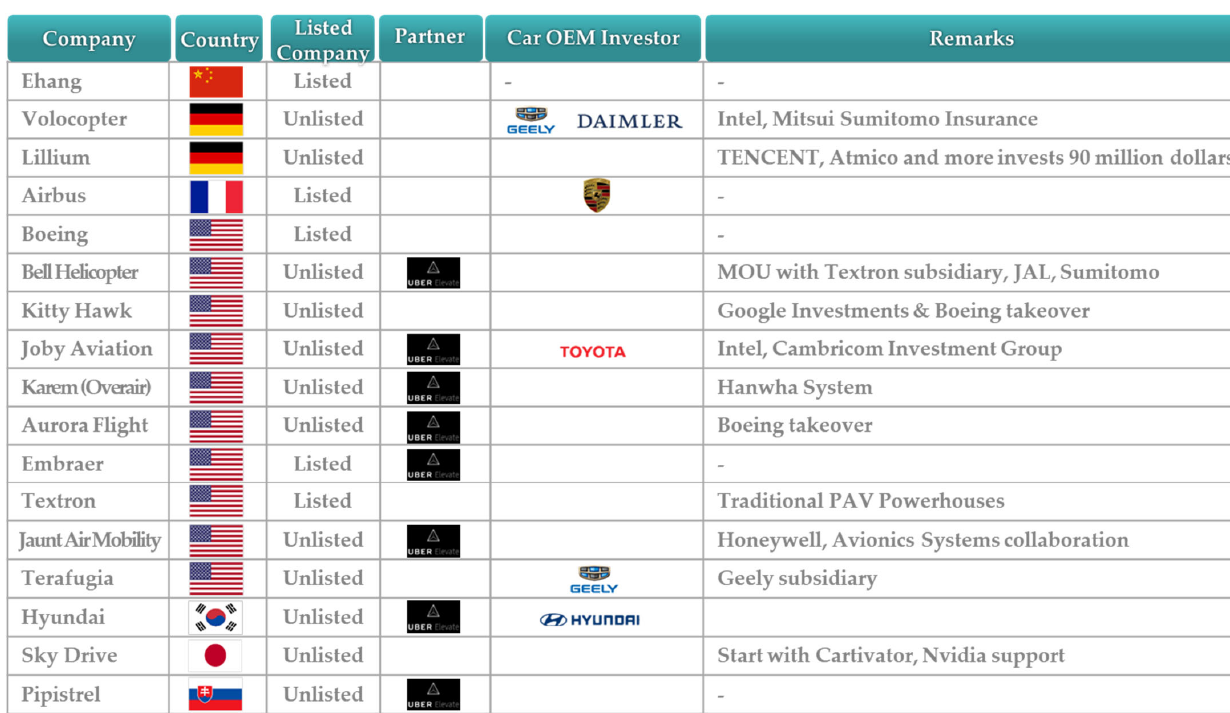
Figure A2. UAM startup investment and partnership status.